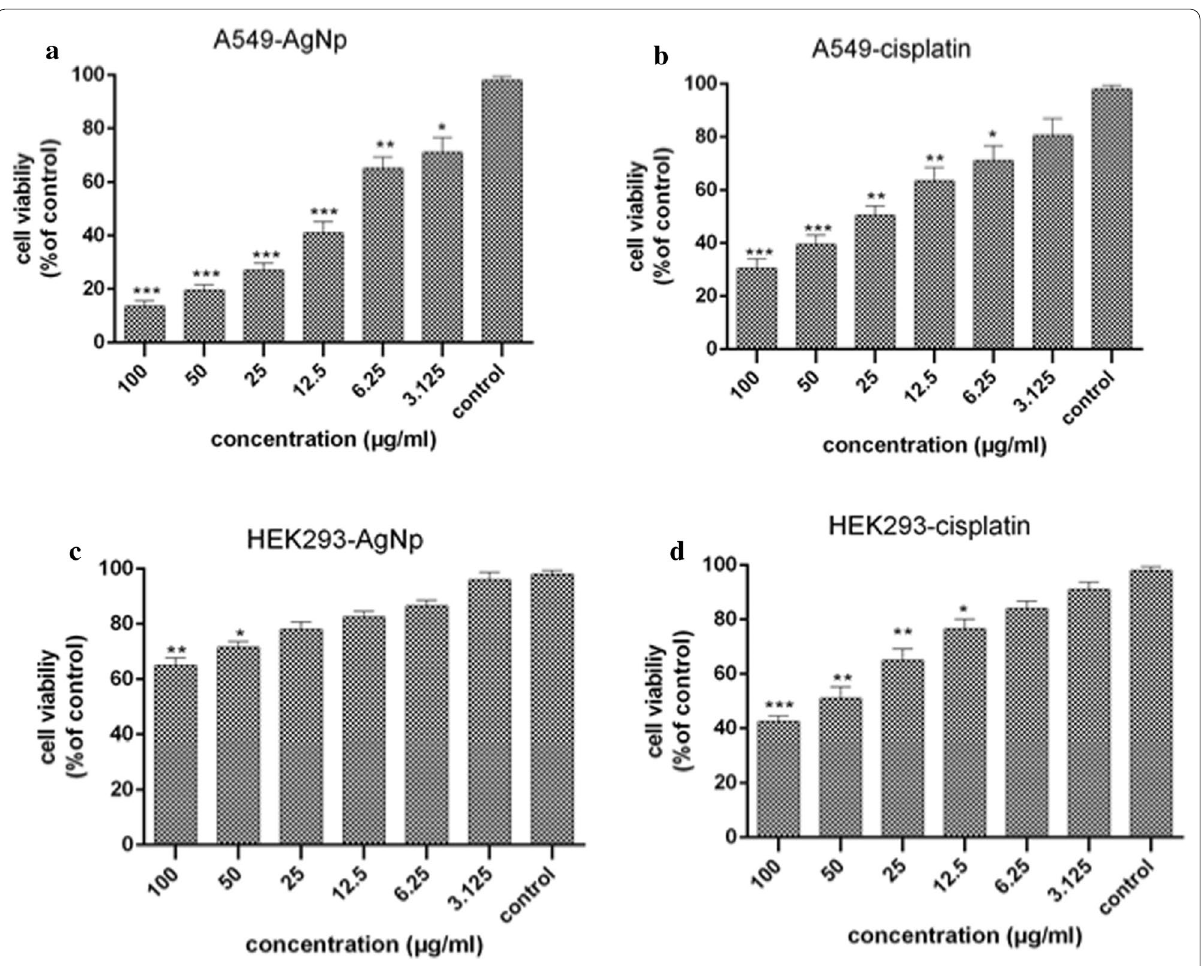
Fig. 5 Viability of A549 and HEK293 cells upon exposure to different concentrations of bio-synthesized AgNPS and cisplatin. *indicate significant difference compared with control. (***P < 0.001, **P < 0.01 and **P < 0.05)